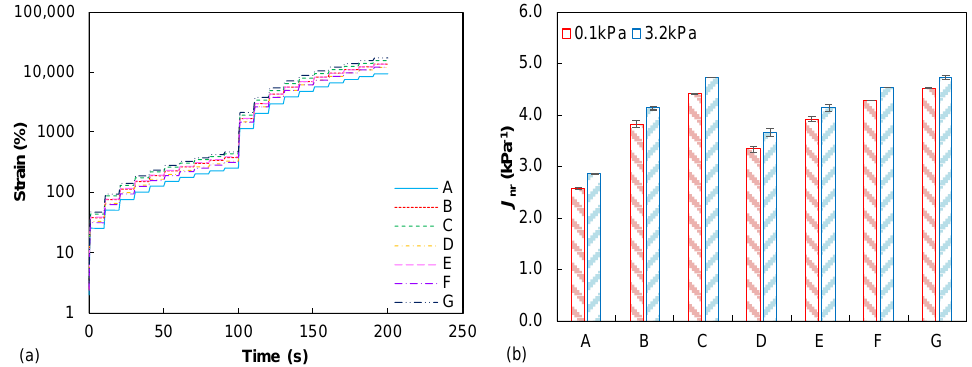
Figure 4. MSCR test results: ( a ) recorded time–strain curves; ( b ) comparison of J nr values.